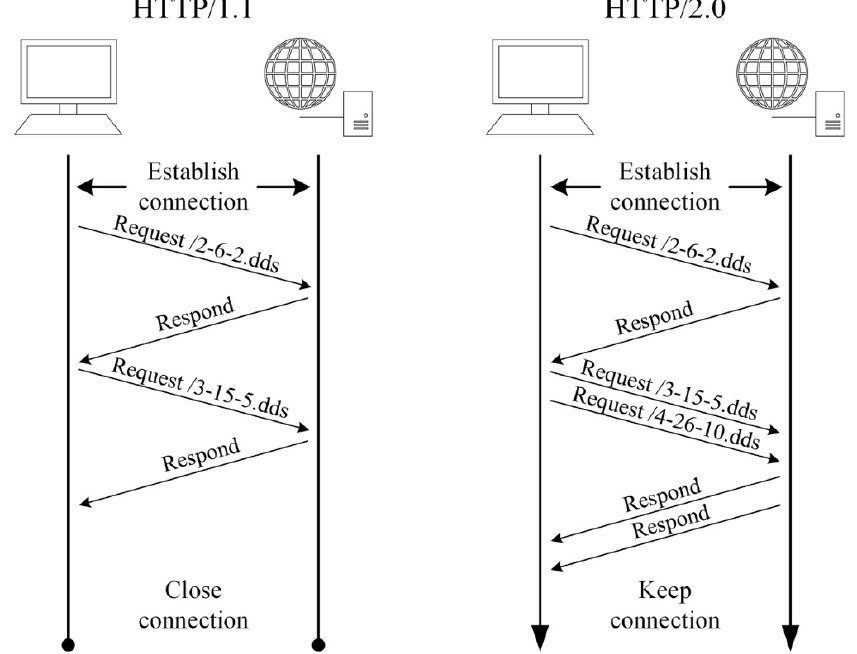
Figure 8. HTTP/2.0 multiplexing tile transmission process.